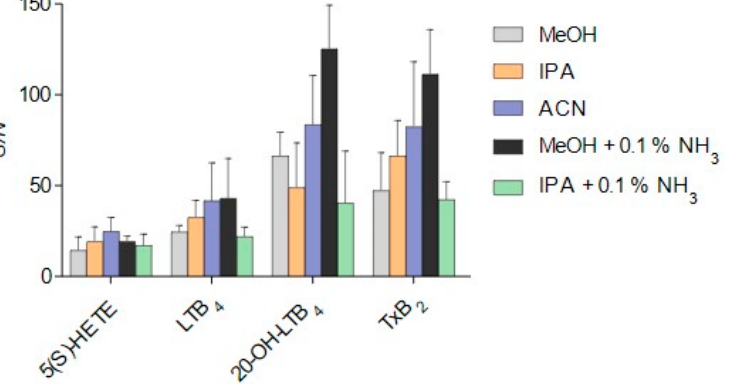
Figure 4. Impact of different makeup compositions on S/N after injection of a standard mixture with 50 ng/mL of each analyte. Measurements were taken on three consecutive days. Results are expressed as mean + SD.